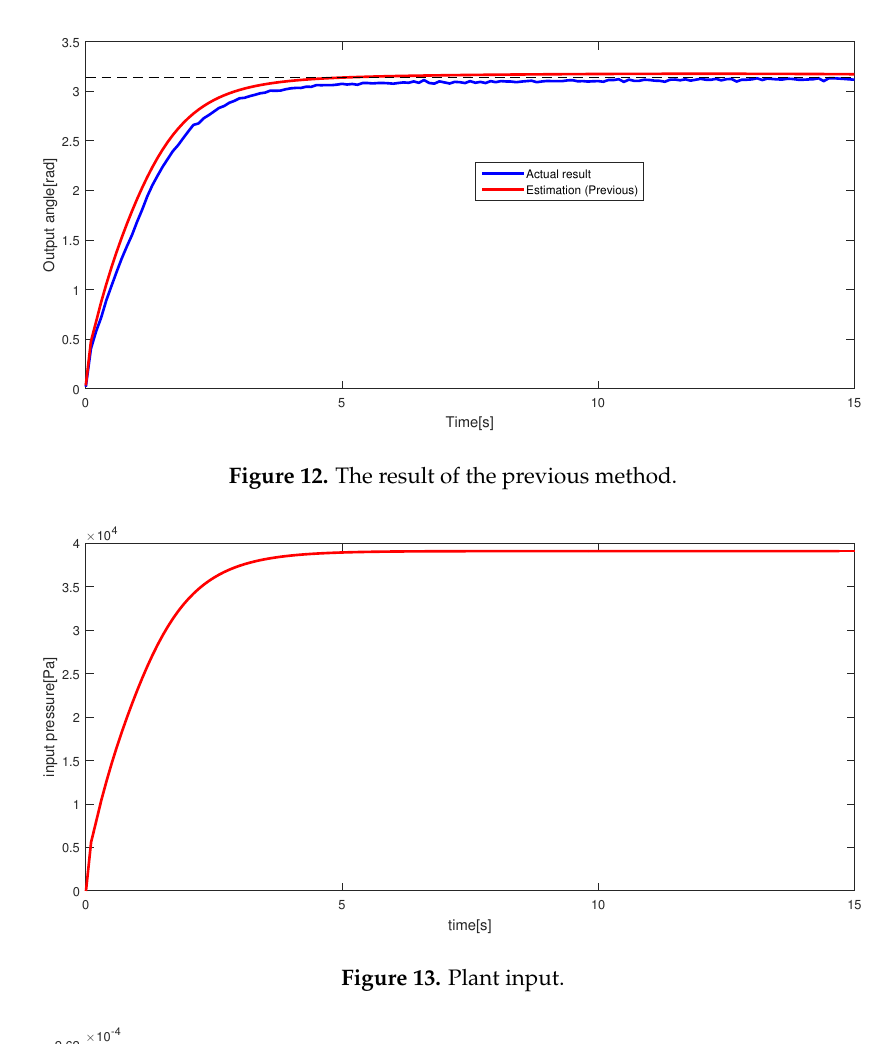
Figure 13. Plant input.